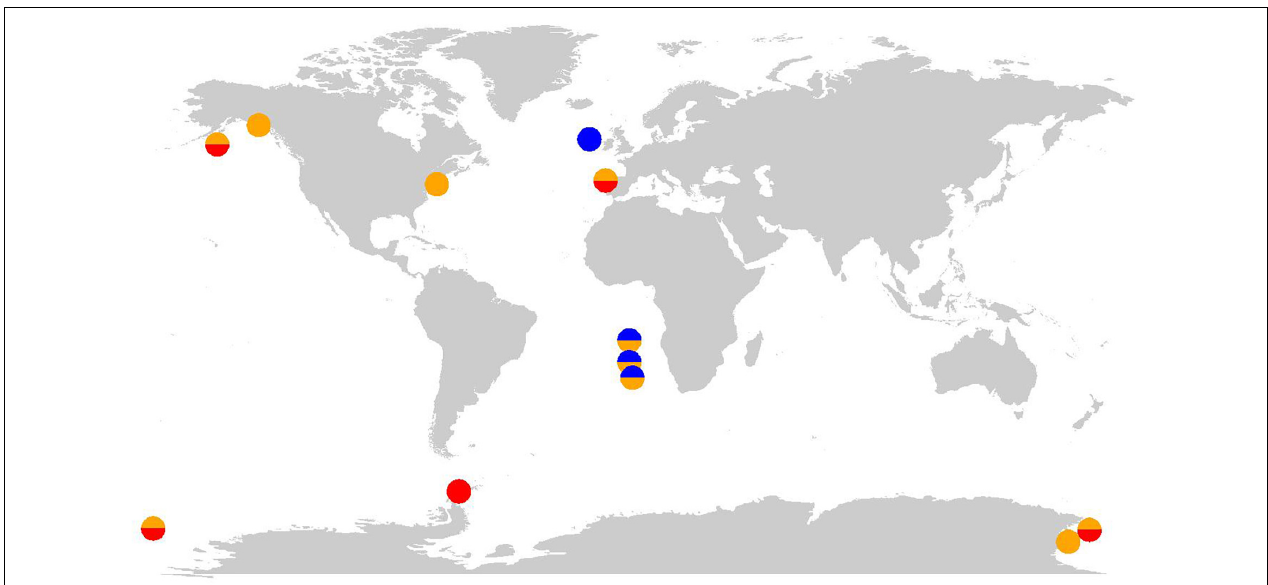
FIGURE 2 | Global map indicating study sites where cobalamin co-limitation was observed. The color of circles indicates the presumed case or cases of CIC. Blue: Case A, orange: Case B, and red: Case C.